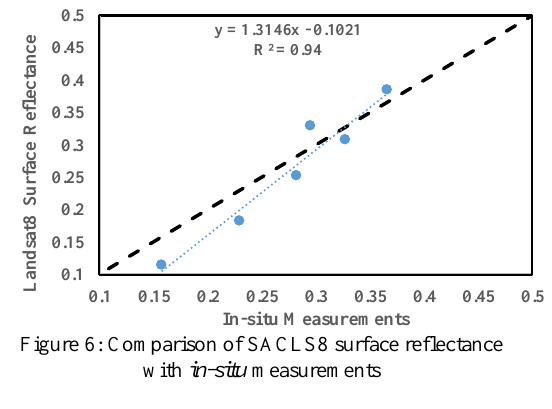
Figure 5: Comparison of Landsat-8 surface reflectance with in-situ measurements